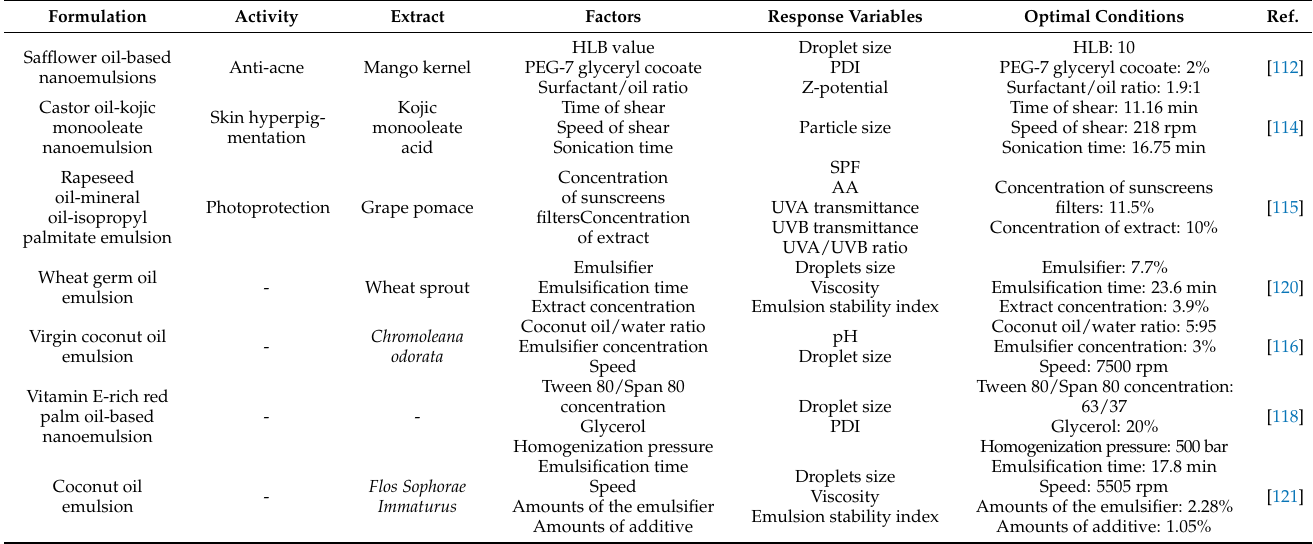
Table 5. Application of experimental design for optimization of cosmeceutical